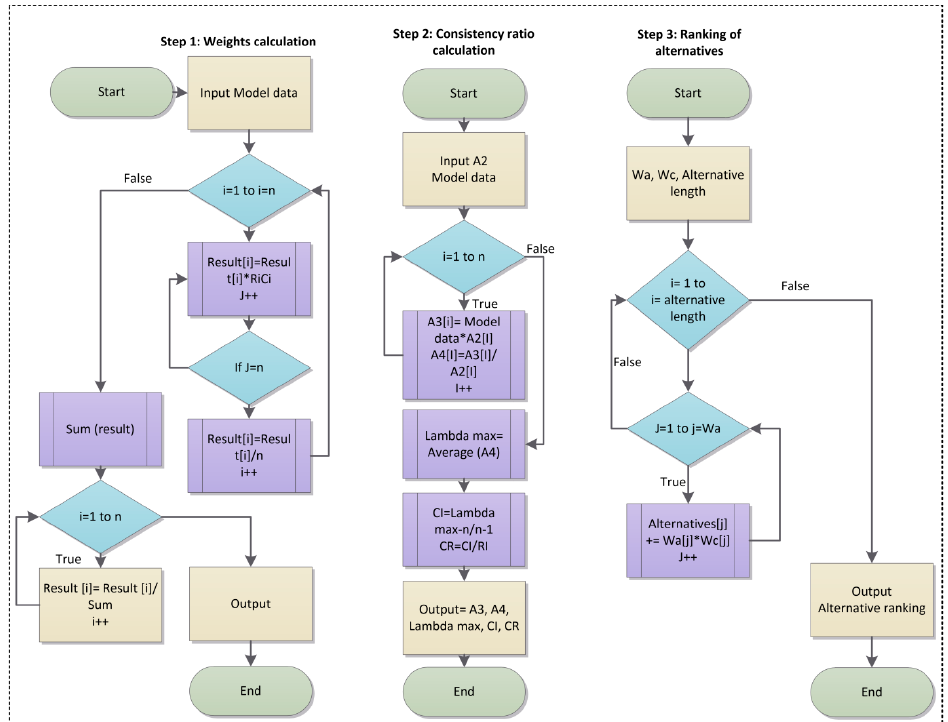
Figure 2. Working procedure of the suggested OffshoringDSS.